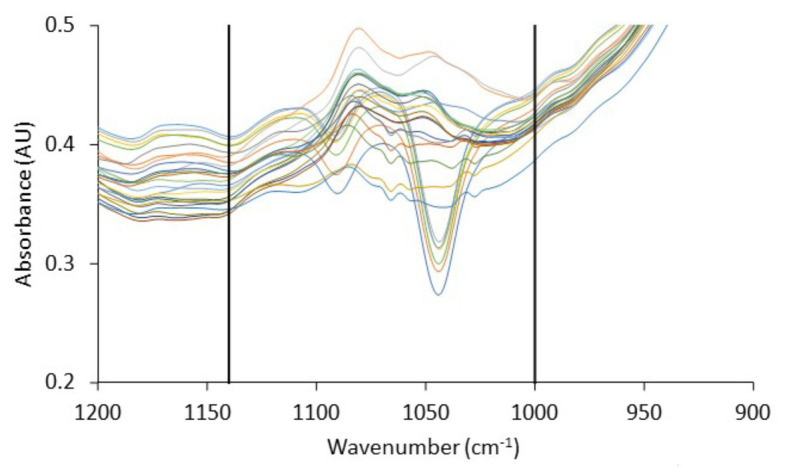
Fourier-transform infrared spectra, in the wavenumber range 1,200–900 cm−1, corresponding to fresh (0 h) chicken liver samples from the different batches used in the current study. Vertical lines delimit the wavenumber range (1,140–1,000 cm−1) in which significant inter- and intra-batch variability is observed.